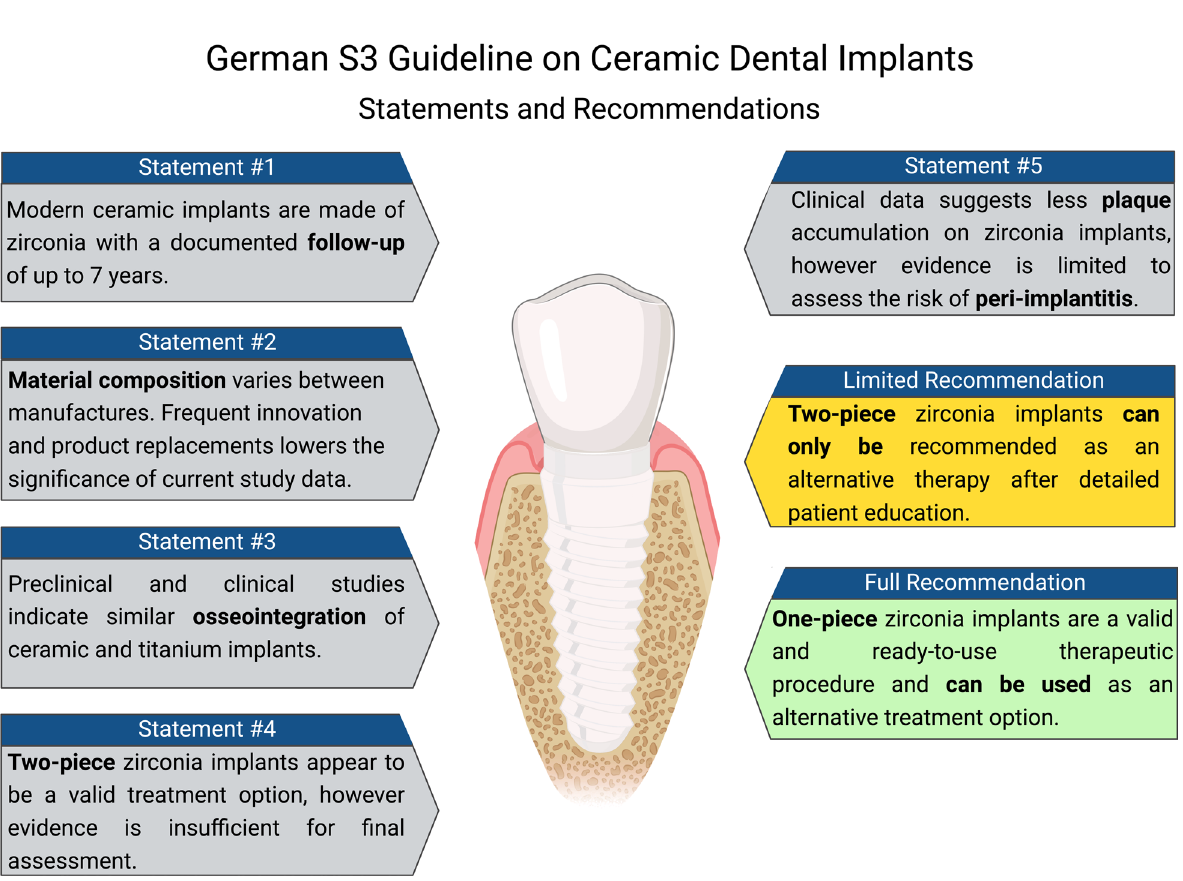
Fig. 1 Illustration of the contents and recommendations of the S3 guideline on ceramic